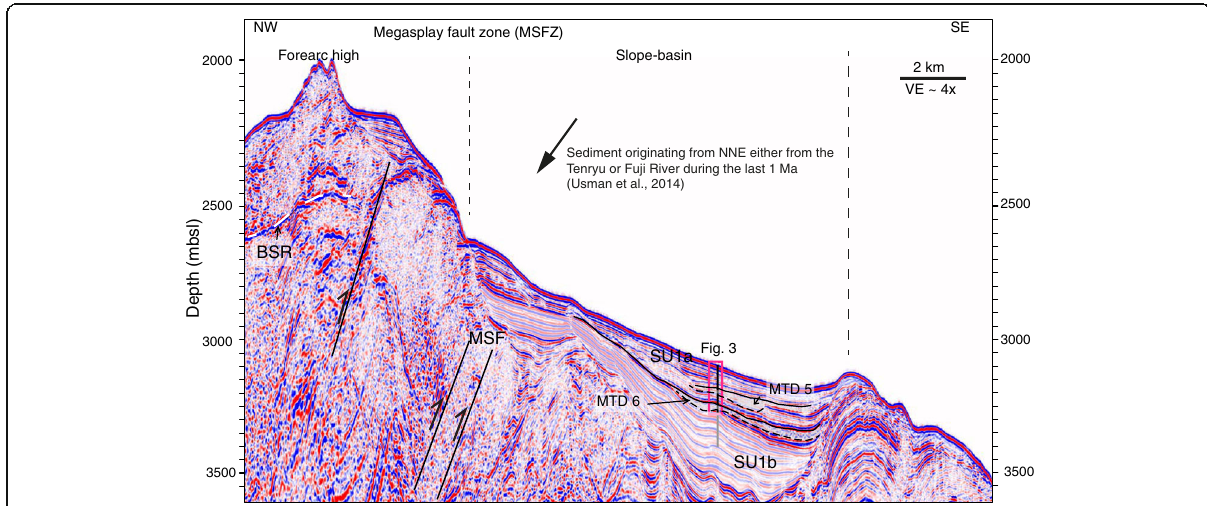
Fig. 2 Seismic reflection profile showing the stratigraphic succession of the lower slope basin downslope of the forearc high and the megasplay fault zone (MSF). The multiple stacked MTD features ( dashed black lines represent the bases of MTDs, continuous black lines the tops of the MTDs) can be identified on the seismic reflection profile. Bottom-simulating reflector (BSR; white dashed line ) is indicative of the occurrence of gas hydrate-laden sediments. Site C0018 ( black bar ) is located within the slope basin. SU1a seismic unit 1a, SU1b seismic unit b ( white transparent area marks the limits of